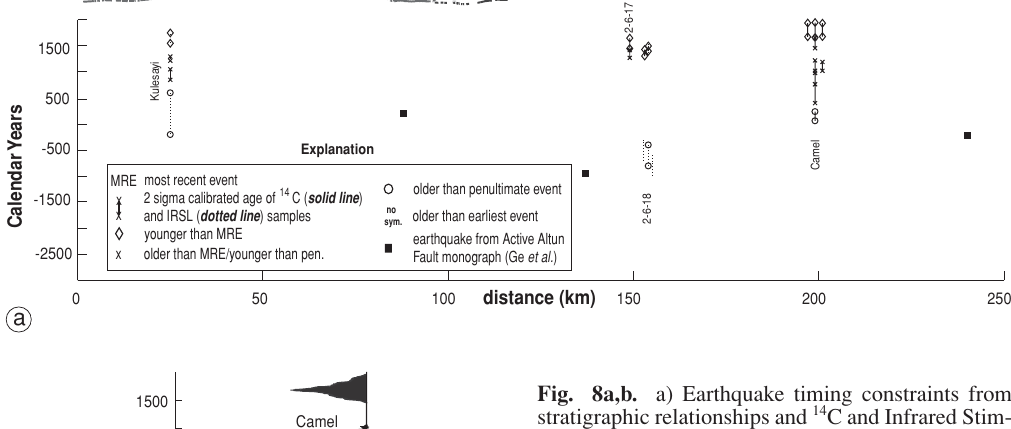
Fig. 8a,b. a) Earthquake timing constraints from stratigraphic relationships and 14 C and Infrared Stim- ulated Luminescence (IRSL) samples (from this study and Washburn et al. , 2001). Note the active trace map above plot A for reference. These are the calibrated ages without OxCal or other refinements from stratigraphic ordering. b) Monte Carlo proba- bility plot for the Camel paleoseismic site earthquake timing data (Hilley and Young, 2003). The area under the curves represents the probability distribution of the age of past earthquakes. Sharper peaks represent well-constrained events and show the refinement of the Camel event